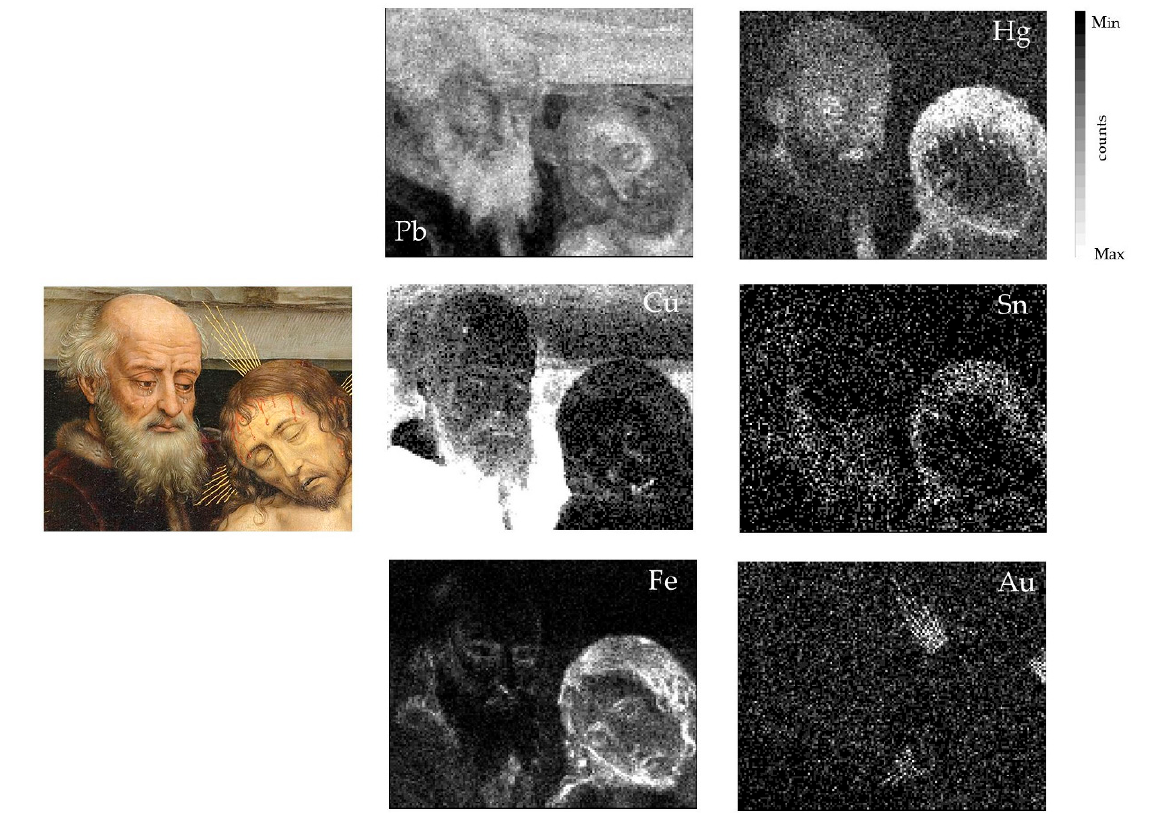
Figure 6. Detail of Joseph of Arimathea and Christ, with relative Pb(L α ), Hg(L α ), Fe(K α ), Cu(K α ), Sn(L α ), and Au (L α ) XRF maps. The grey scale in the Cu map is edited to enhance the distribution in flesh tones and hair.